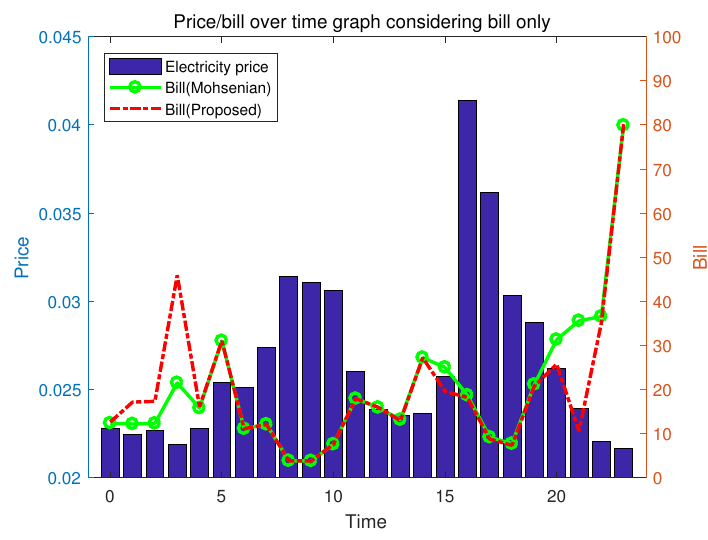
Figure 12. Electricity bill vs. timeslot considering only the electricity bill. The bar is real-time pricing and the plot is the electricity